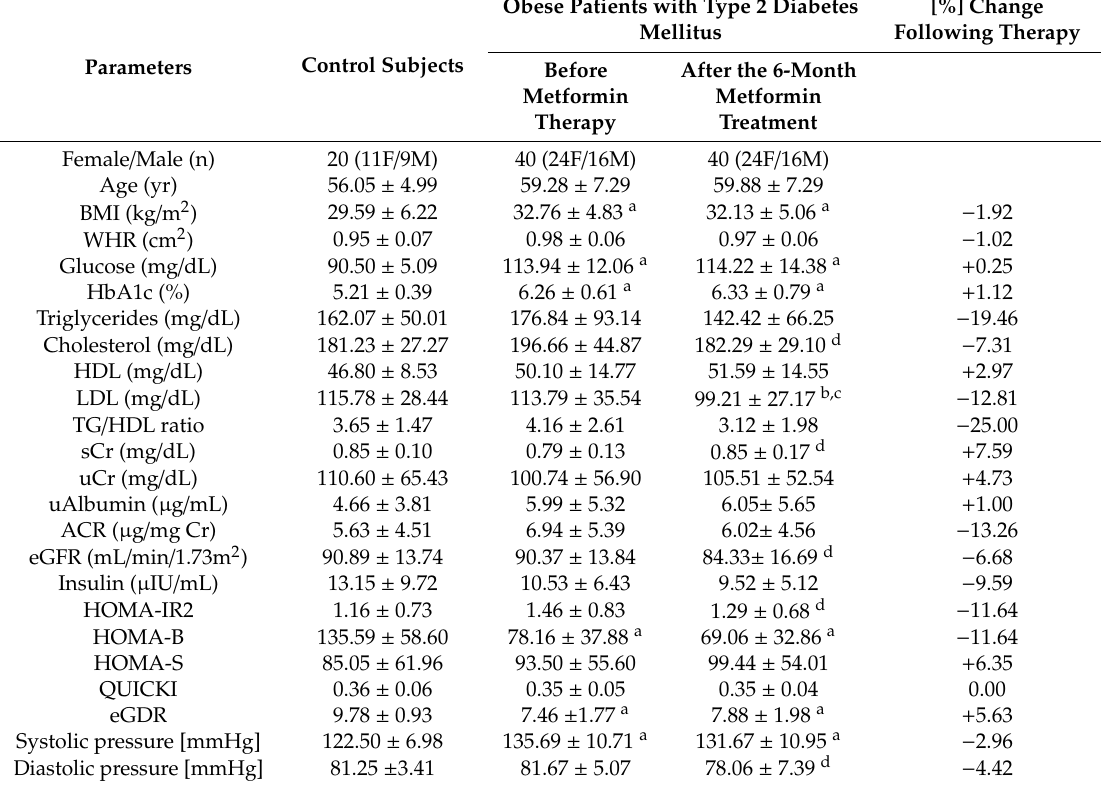
Table 1. Clinical characteristics of control subjects and obese patients with type 2 diabetes